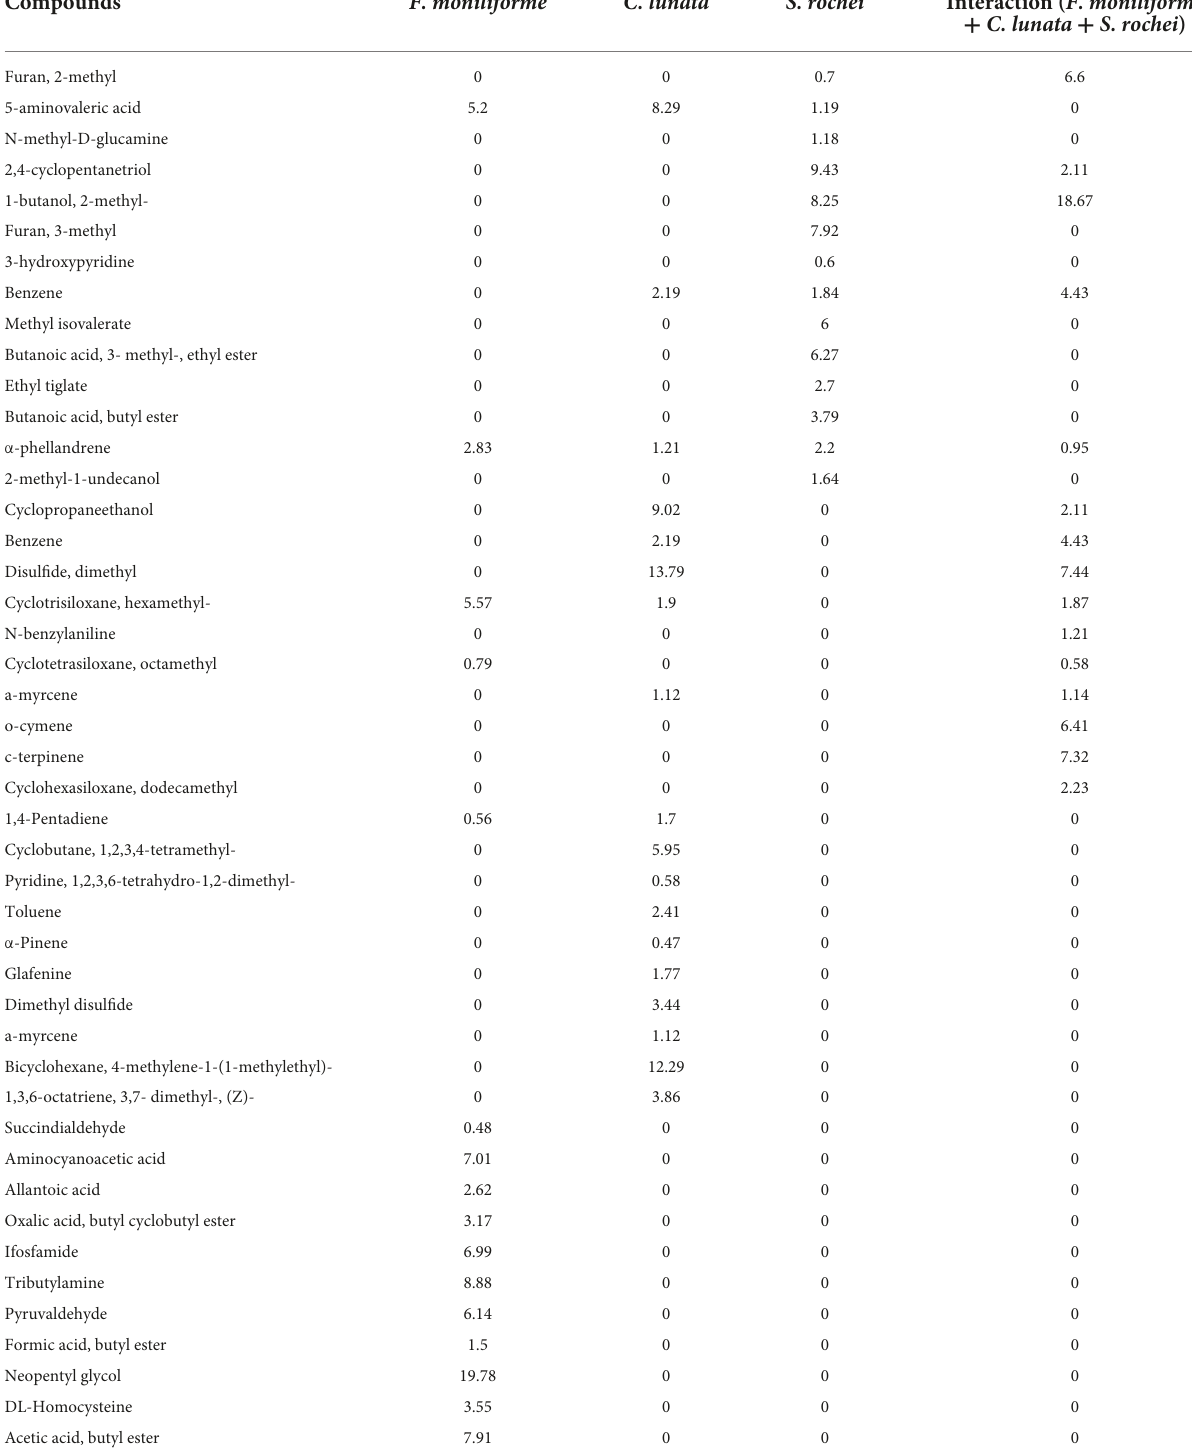
TABLE 1 Compounds obtained during axenic and co-culture by GC-MS analysis.